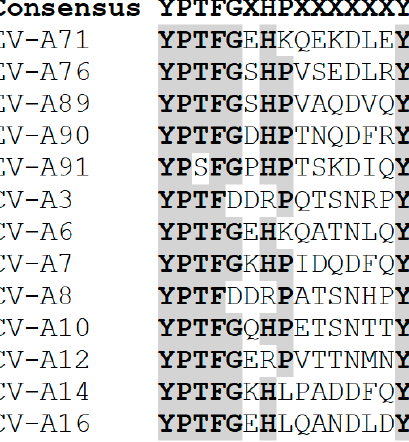
Figure 2. Multiple sequence alignment of SP70 motif from various Enterovirus A viruses. The SP70 motif of Enterovirus A species can be denoted as YPTFGX 1 HPX 2 X 3 X 4 X 5 X 6 X 7 Y. The consensus amino acid is highlighted in grey and in bold.